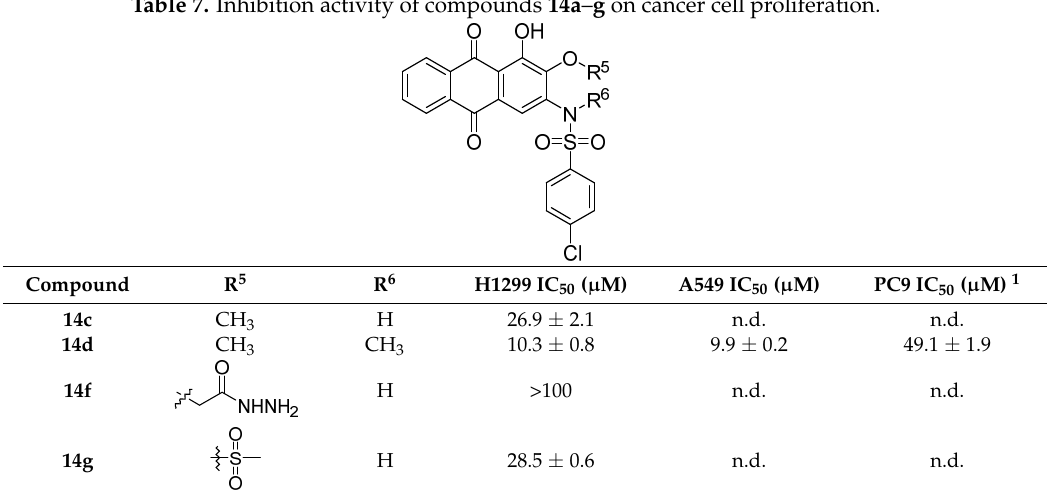
Table 7. Inhibition activity of compounds 14a – g on cancer cell proliferation.